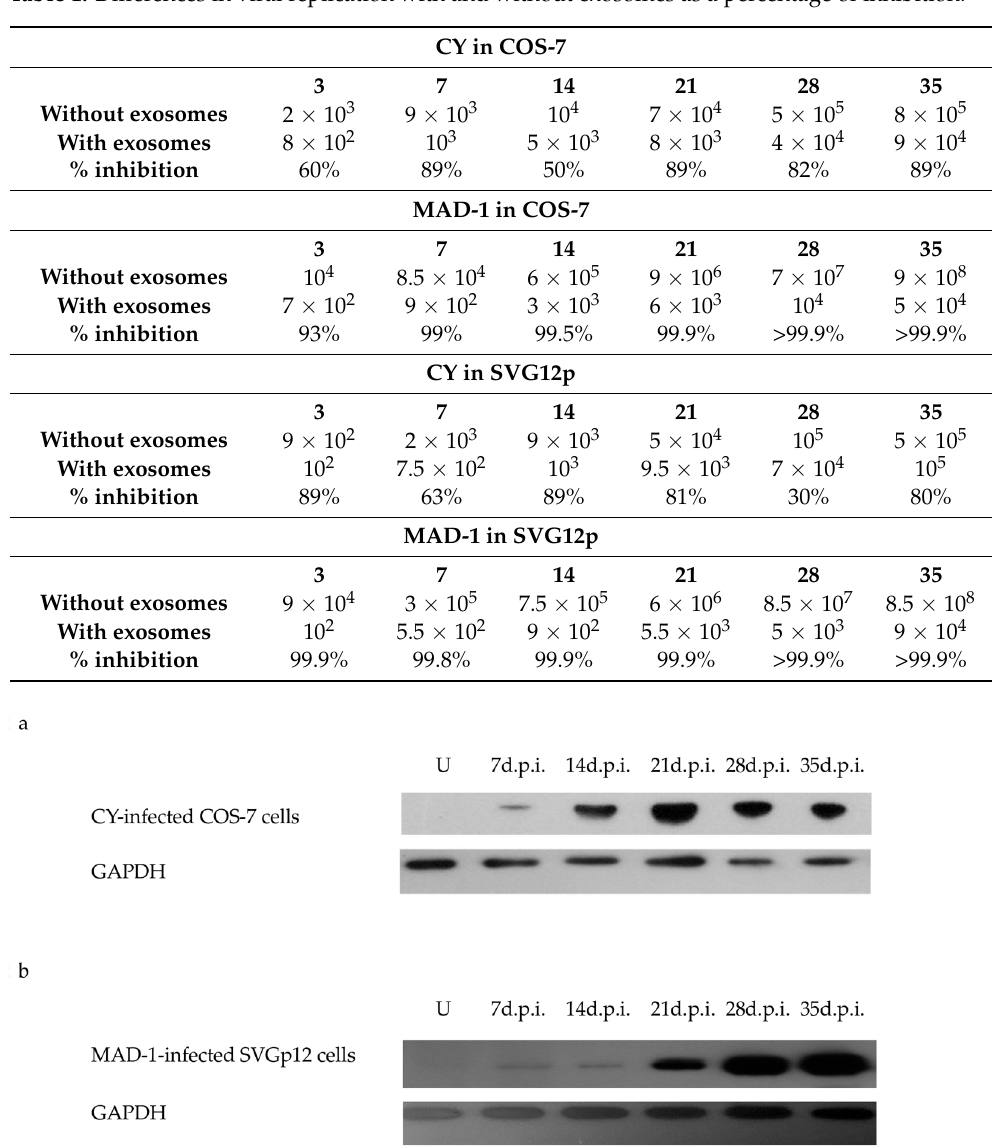
Figure 5. WB analysis of the VP1 protein expressed in CY- and MAD-1-infected cells after infection. Cell protein extracts from uninfected (U) and infected COS-7 and SVGp12 cells were harvested at 7 d.p.i., 14 d.p.i., 21 d.p.i., 28 d.p.i., and 35 d.p.i., and analyzed by WB to evaluate the expression of the VP1 protein. Equal amounts of protein from whole-cell protein extracts were separated by SDS–PAGE, transferred to PVDF, and probed using anti-VP1 antibody. Normalization to the host cell number (VP1/GAPDH) was performed. ( a ) Results showing that the VP1 protein in the CY-infected COS-7 cells was expressed 7 d.p.i., and its level increased during the infection experiments, reaching the maximum expression at 21 d.p.i., although remaining detectable for up to 35 d.p.i. ( b ) Results showing that the VP1 protein in the MAD-1-infected SVGp12 cells was expressed 7 d.p.i., and its level increased during the infection experiments, reaching the maximum expression at 35 d.p.i.